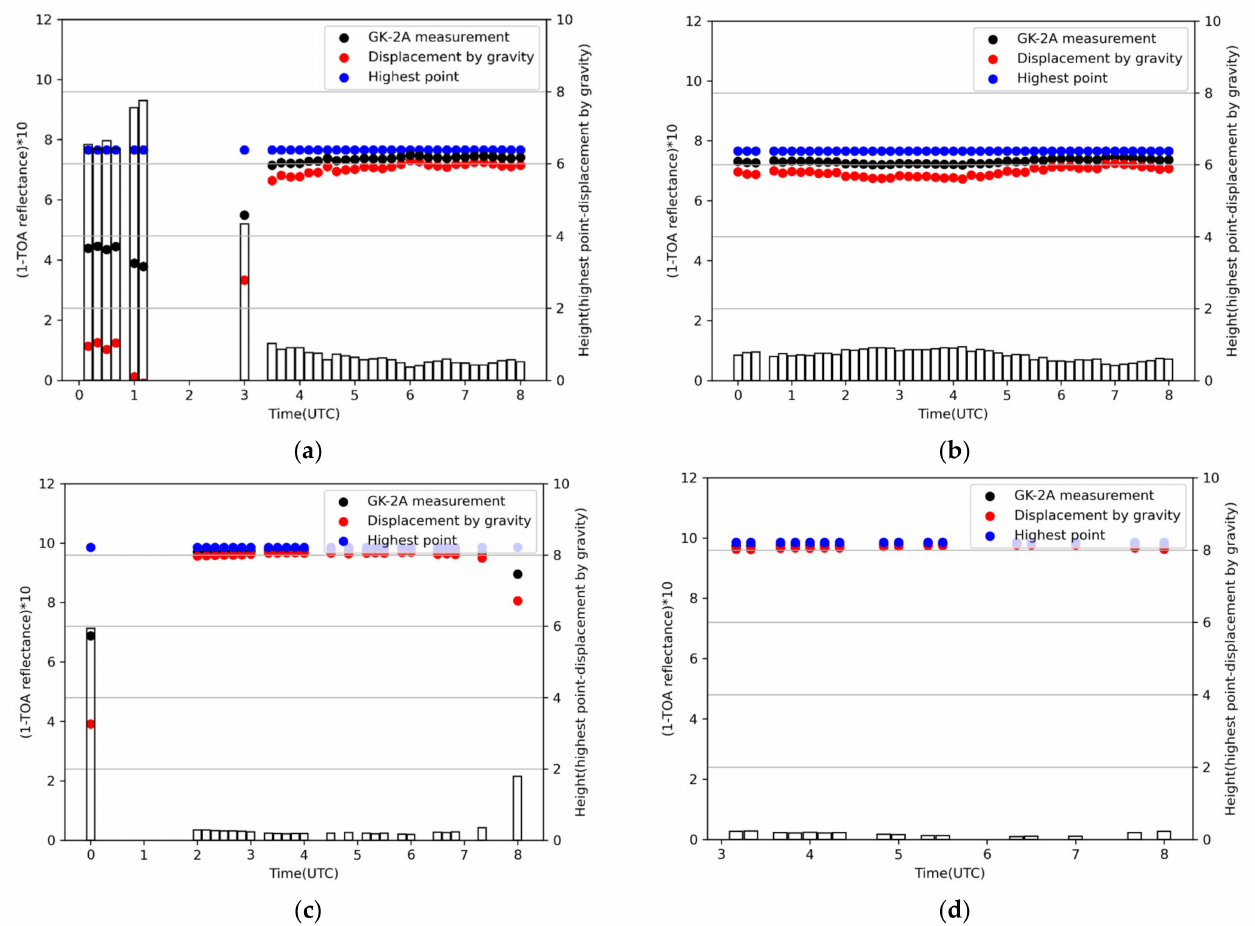
Figure 5. Graph of filtering process using minimum TOA reflectance. The TOA reflectance in the imagery were converted to ( 1 − TOA reflectance ) × 10. The bar graph indicates the difference between blue and red dots, the blue point indicates the minimum TOA reflectance, the red point indicates the value calculated by Equation (4), and the black point indicates the real TOA reflectance. Comparison between target (Displacement by gravity) and minimum TOA reflectance (Highest point) on land (36.76 ◦ N/127.48 ◦ E) ( a ) 7 June 2020 and ( b ) 8 June 2020; ( c , d ) are comparison on sea (39.01 ◦ N/128.58 ◦ E) ( c ) 10 June 2020 and ( d ) 8 June 2020; ( a , c ) mean that the values change when clouds flow into or disappear the specific pixel, and ( b , d ) mean